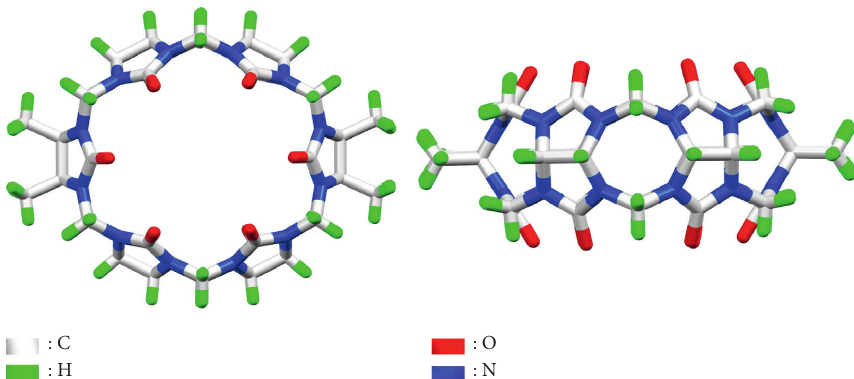
Figure 1: Structure of Symmetric tetramethylcucurbit[6]uril (TMeQ[6], C